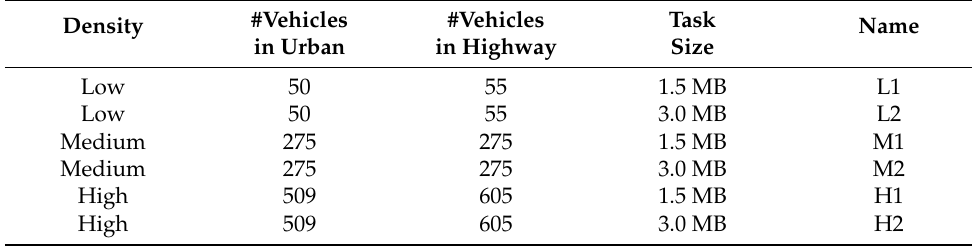
Table 5. Factors and levels considered in the experiments.